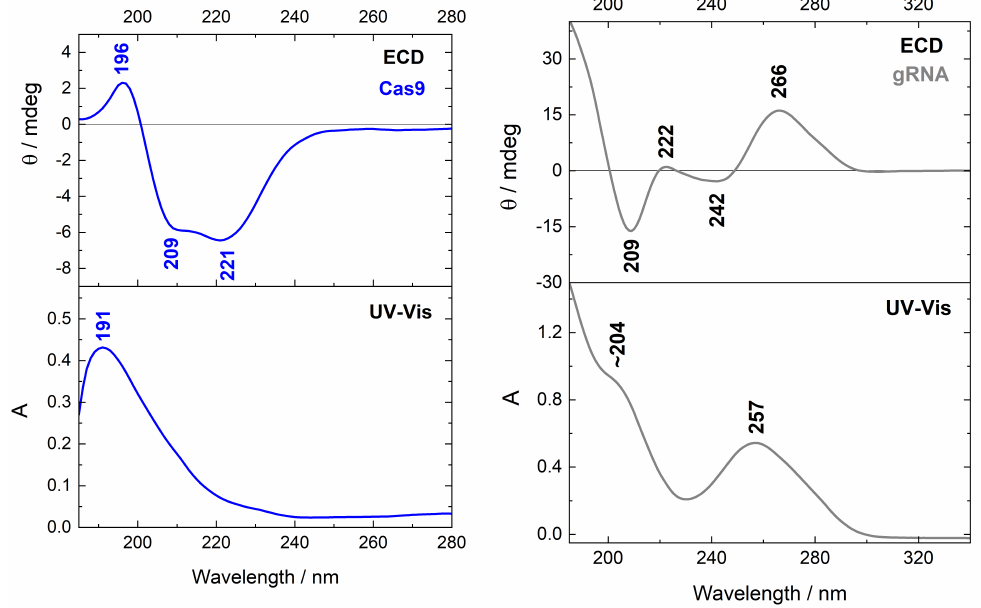
Figure 3. ECD and UV-Vis spectra of Cas9 protein (blue line, C = 9.35 × 10 − 7 M) and gRNA (gray line, C = 1.07 × 10 − 5